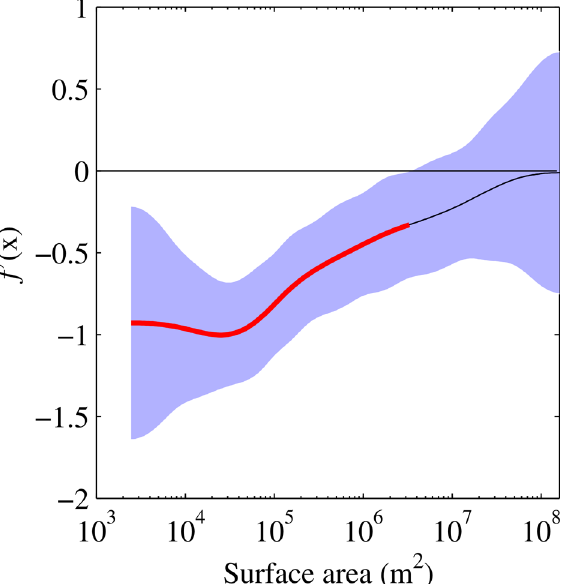
Fig 4. First derivatives of the fitted generalised additive model. The red line indicates those parts of the model fit that are statistically significantly changing and the shaded region shows the 95% confidence